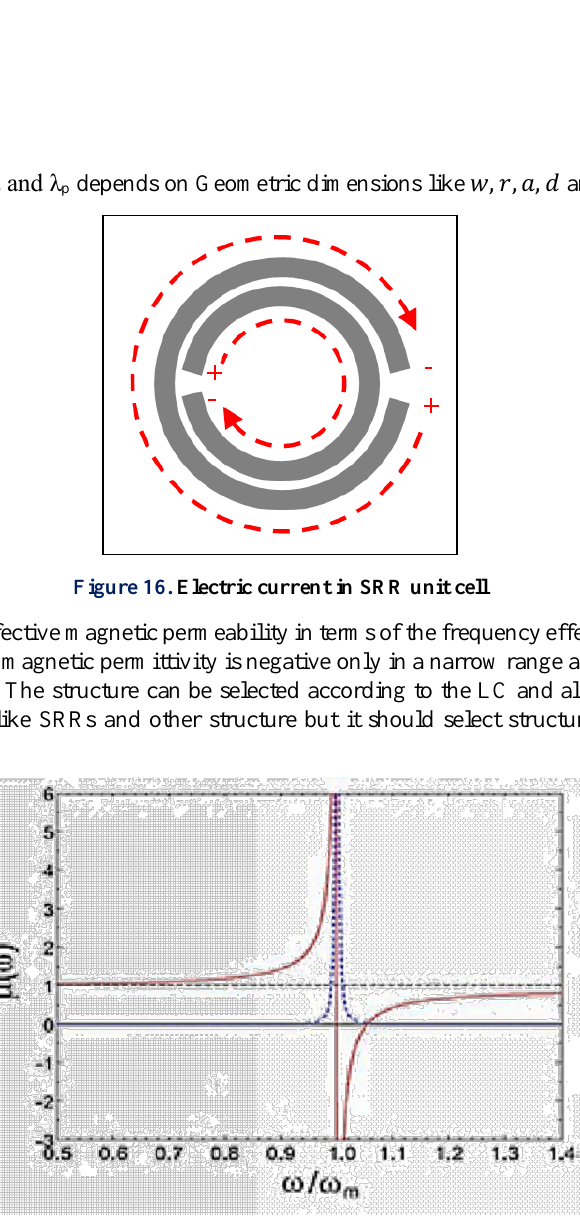
Figure17. Effective magnetic permeability in terms of the